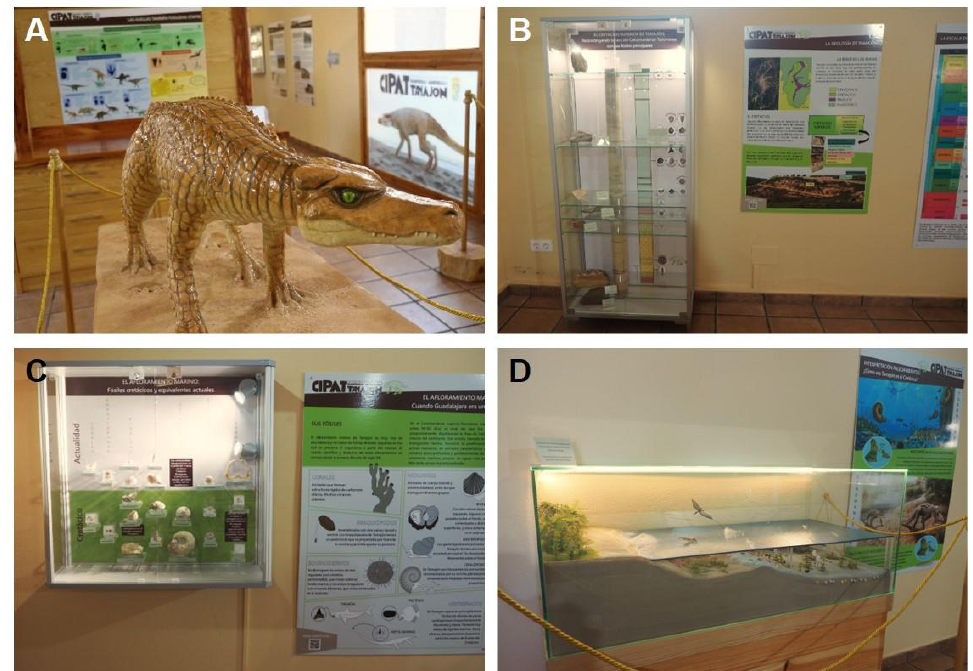
Figure 5. ( A ) Detailed image of the reconstruction of a crocodylomorph, producer of the ichnites found in the Upper Cretaceous of Tamajón (Guadalajara, Spain), on themed surface, as central out- standing piece of the Paleontological Area of the Paleontological and Archaeological Interpretation Centre of the locality (CIPAT); ( B ) Photograph of the display case of the same area with the recrea- tion of the Cenomanian-Turonian lithological section of Tamajón, which includes the Utrillas, Villa de Vés and Picofrentes formations, and the lower part of the Ciudad Encantada Formation, showing on its right the panel “La Geología de Tamajón - The Geology of Tamajón” ; ( C ) Image of the display case of the same area with representative fossils of Tamajón and, on the right, the panel “El afloram- iento marino: Cuando Guadalajara era un mar- The marine outcrop: When Guadalajara was a sea” ; ( D ) Photograph of the diorama of the CIPAT Paleontological Area, representing different Upper C retaceous transitional and marine ecosystems of Tamajón, showing on its right the panel “Inter- pretación paleoambiental: ¿Cómo era Tamajón en el Cretácico-Paleoenvironmental interpretation: How was Tamajón during the Cretaceous?”.